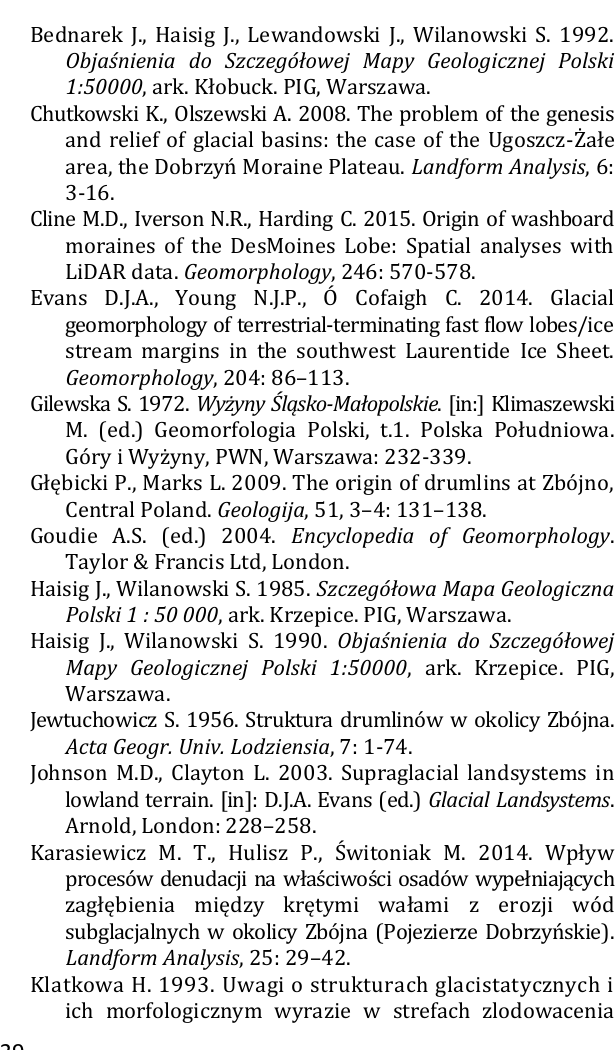
Fig. 4. Sketches depicting subsequent stages of the Odra ice sheet advancing into the Wieluń Upland (after Różycki & Lamparski, 1967, simplified) a – initial stage, b – final stage. LS – Silesian lobe, LW – Widawka lobe. The dotted line indicates the location of the ice wall, arrows – the directions in which the ice sheet advances, and the green square – the study